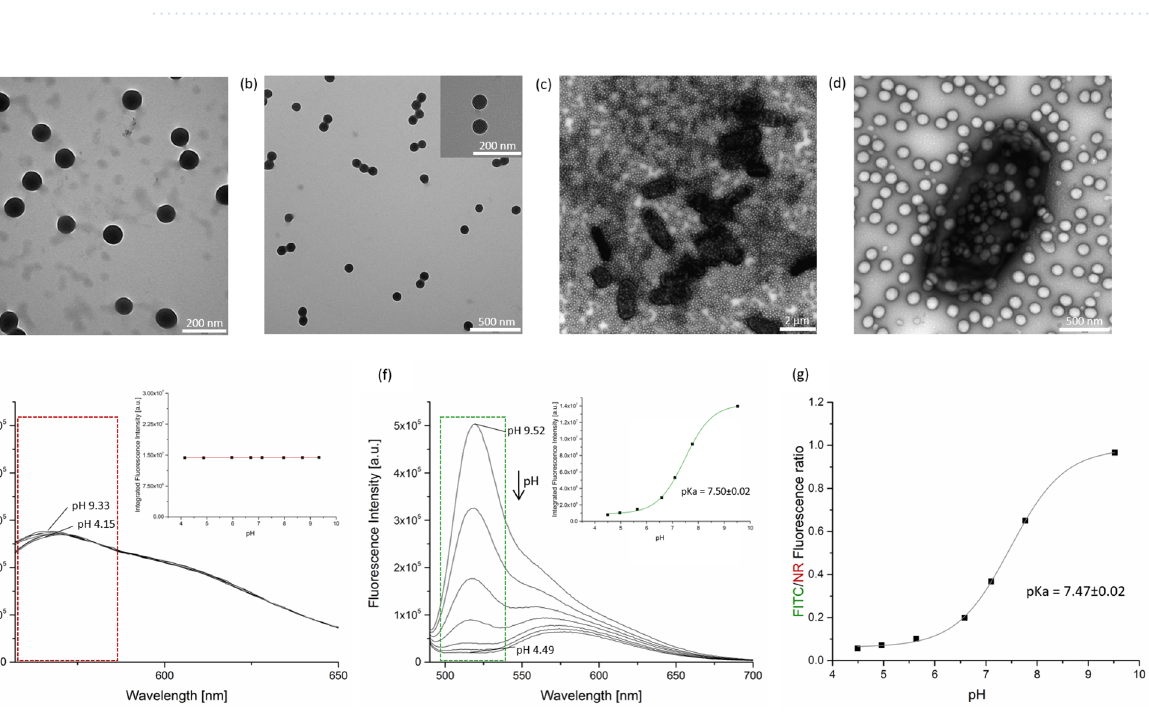
Figure 2. Characterization of the nanosensor. ( a ) TEM image of the precursor PS NP in water. ( b ) TEM image of the nanosensor in water. ( c ) and ( d ) TEM images of E. coli cells and nanosensor after 24 h incubation with 1 mg/ml nanosensor in M9 minimal medium. ( e ) Fluorescence spectra of the nanosensor excited at 530 nm (NR) in 7 buffers with different pH. Inset: Integrated FI (red box = area of signal integration) plotted against the pH value of the respective buffer. ( f ) Excited at 480 nm (FITC). Inset: Sigmoidal fit of the integrated FI (green box = area of integration) plotted against the pH value of the respective buffer. ( g ) Ratio of the integrated FI of the green FITC and the red NR emission plotted against the corresponding pH with sigmoidal curve